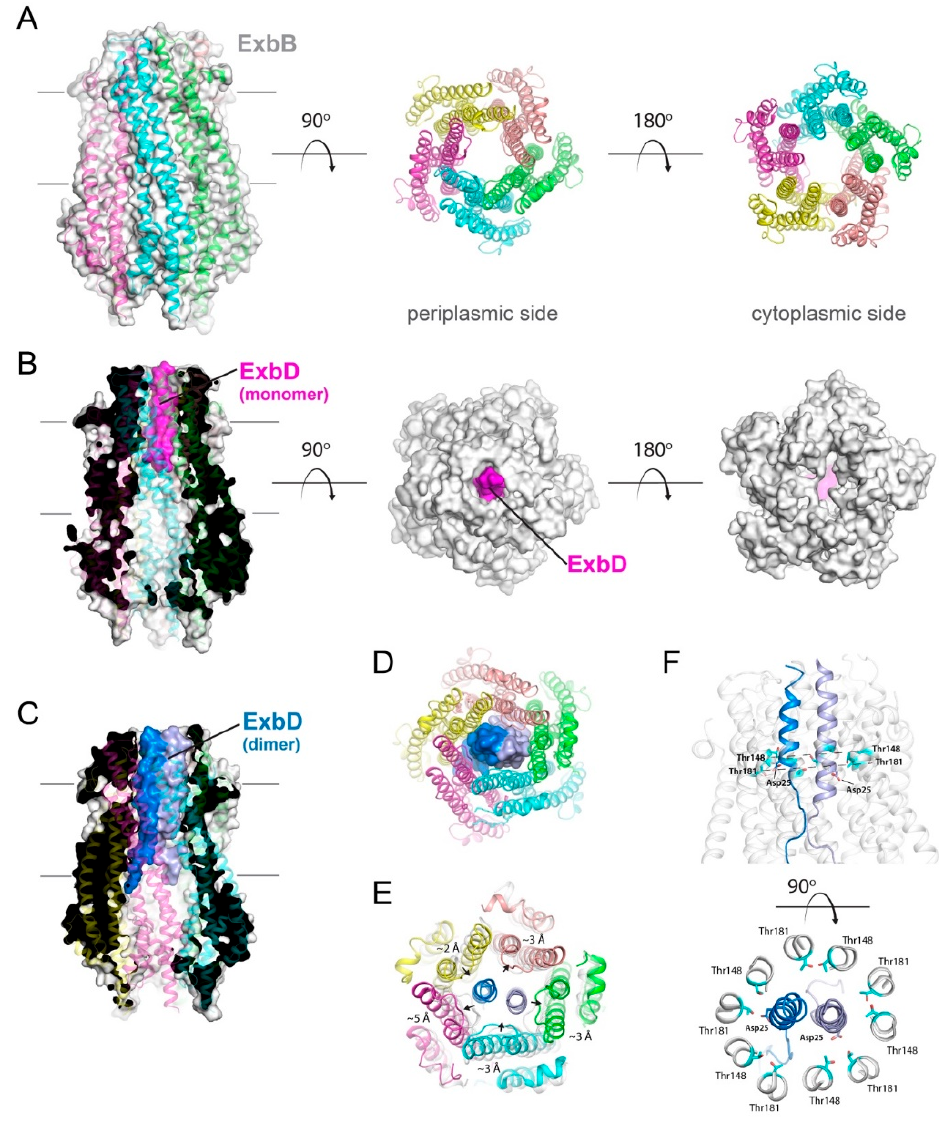
Figure 4. Structures of the pentameric ExbB/D subcomplex. ( A ) The X-ray structure of the ExbB/ExbD subcomplex (PDB ID 5SV0) shown in ribbon and surface. Here, ExbB is a pentamer which has pseudo 5-fold symmetry on the periplasmic side and 5-fold symmetry on the cytoplasmic side. In this structure, solved at neutral pH, ExbD was mostly disordered and missing in the electron density. A cryoEM structure of the pentameric form of ExbB was also recently reported (PDB ID 5ZFV). ( B ) The X-ray structure of the ExbB/ExbD subcomplex (PDB ID 5SV1) at low pH. In this structure, the transmembrane helix for ExbD (magenta) was observed inside the pore of the ExbB pentamer and offset from the plane of the membrane, as shown in the cutaway representation on the left panel. ( C ) The cryoEM structure (PDB ID 6TYI) showing a dimeric form of ExbD sitting within the pentameric pore of ExbB. ( D ) A view of the cryoEM structure from panel C looking down the pore from the periplasmic side. The ExbD dimer is in surface with each chain in a different shade of blue. ( E ) The same view as in panel D, but depicting the conformational changes observed in ExbB to accommodate the ExbD dimer. The structure from panel A is shown in gray for comparison and the subunit shifts are indicated by the black arrows and approximate measurements noted. ( F ) The cryoEM structure from panel C showing the locations of the conserved residues in ExbB (Thr148 and Thr181) and ExbD (Asp25) that are proposed to play a role in proton transport from the pmf for energy production. A side view is shown in the top panel while a top down view is shown in the bottom panel.